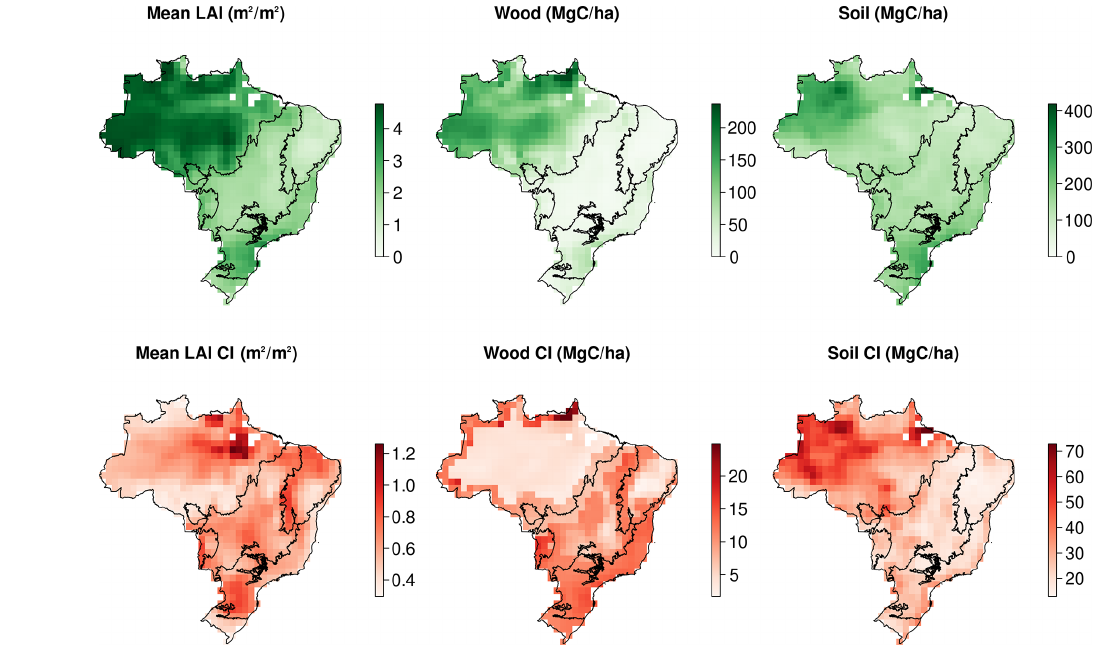
Figure A1. Maps of observational constraints and their associated uncertainties used in the CARDAMOM assimilation framework: mean annual LAI, wood stocks and initial soil stocks.